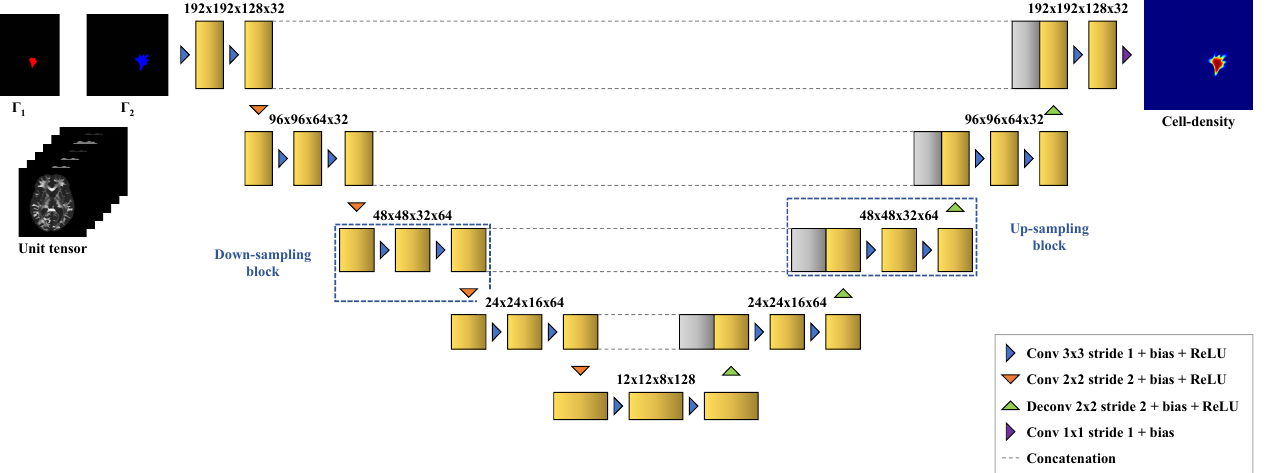
Figure 5. Three-dimensional U-Net architecture [43] with its feature map dimensions used for cell-density estimation. The network takes as input volumes of dimensions 192 × 192 × 128 with 8 channels corresponding to the 2 contours Γ 1 and Γ 2 and the 6 independent components of the unit (unscaled) tumor cell diffusion tensor field, and outputs a cell-density map with the same spatial